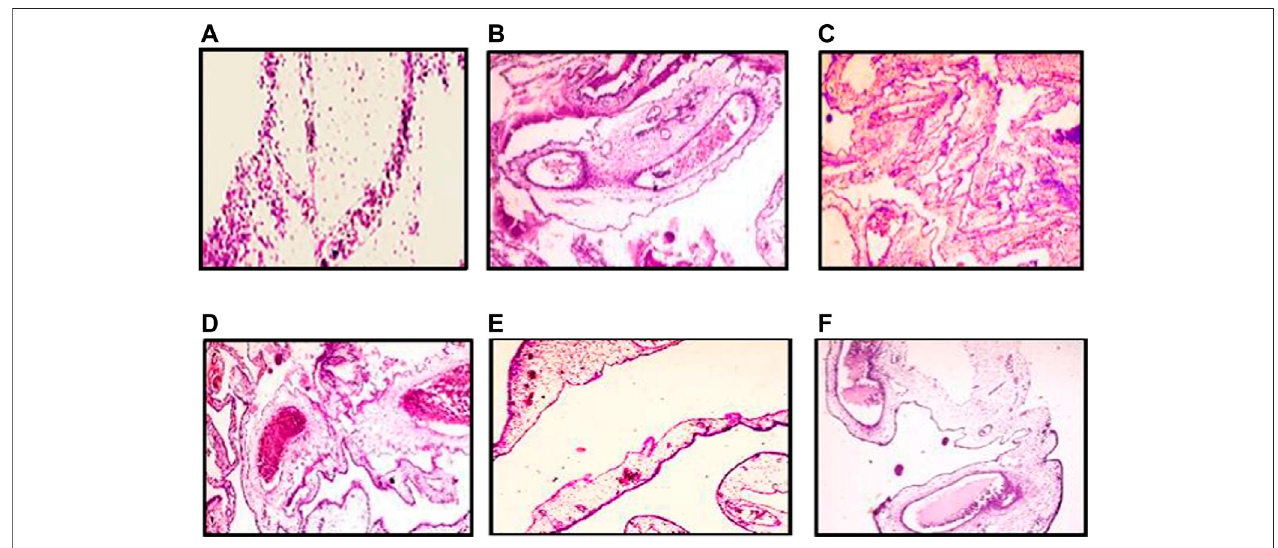
FIGURE 11 | Histopathology pattern of chick embryo chorioallantoic (CAM) assay. (A) Negative control (non-treated). (B) CAM treated with 10 μ g/ml of ZnO nanorods(ZnO-NRs). (C) CAM treated with20 μ g/ml ofZnOnanorods (ZnO-NRs). (D) CAMtreatedwith10 ngofpositivecontrol VEGF. (E) CAMtreatedwith 50 μ g/ml of ZnO nanorods (ZnO-NRs). (F) CAM treated with released Zn (II) ions.